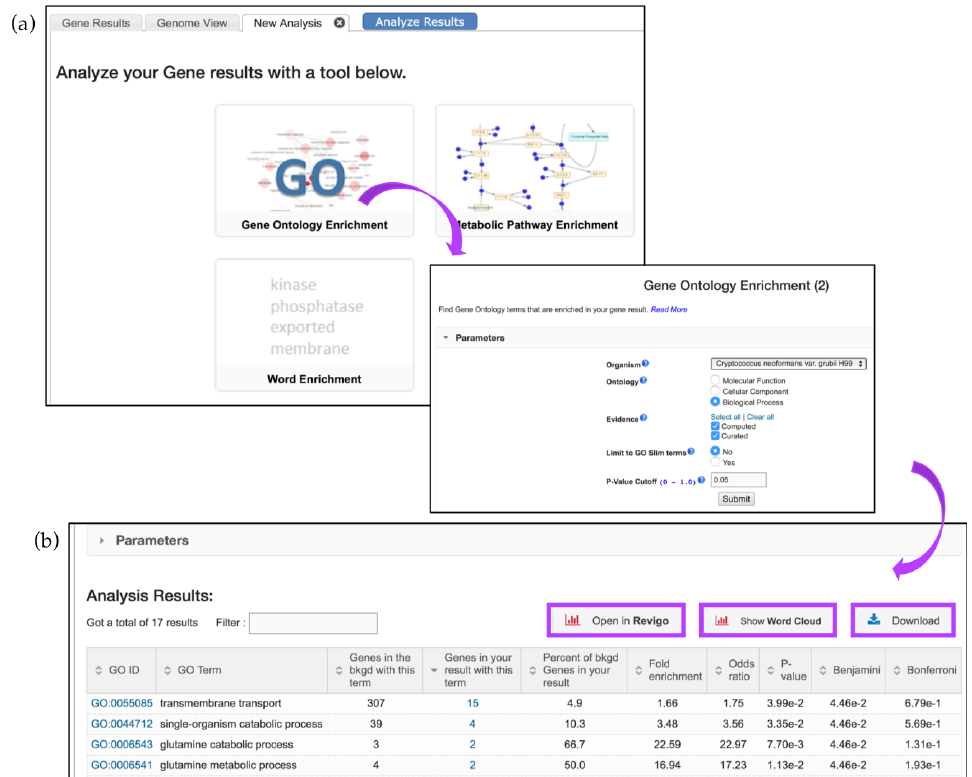
Figure 8. Gene enrichment analysis tools. ( a ) Clicking on the GO — Gene Ontology Enrichment button deploys GO enrichment that can be limited based on the following parameters: ontology aspects, GO evidence ( Computed vs. Curated ), and p -value (0.05 default), or GO Slim terms; ( b ) The enrichment results can be further visualized via Reduce + Visualize Gene Ontology (REViGO), Word Cloud image, or downloaded (highlighted in purple).